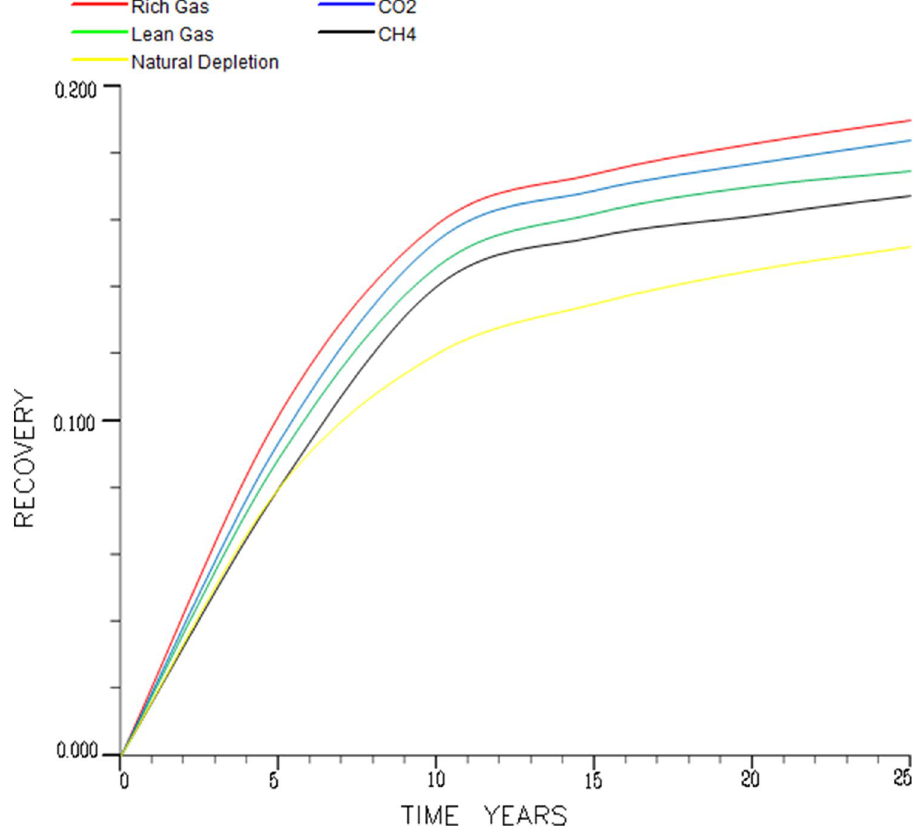
Fig. 4 Oil recovery factor for different injected gases at optimum injection rate